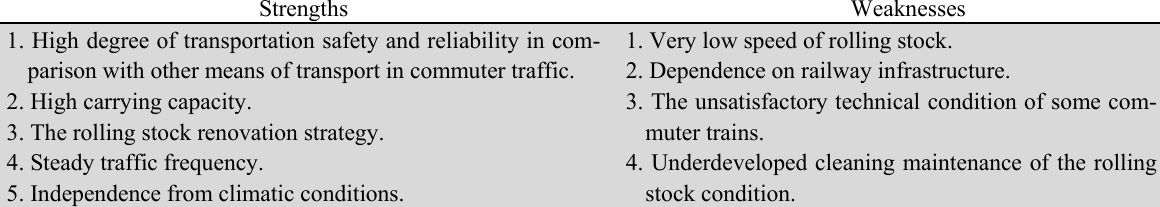
SWOT-analysis of CSPC JSC Strengths